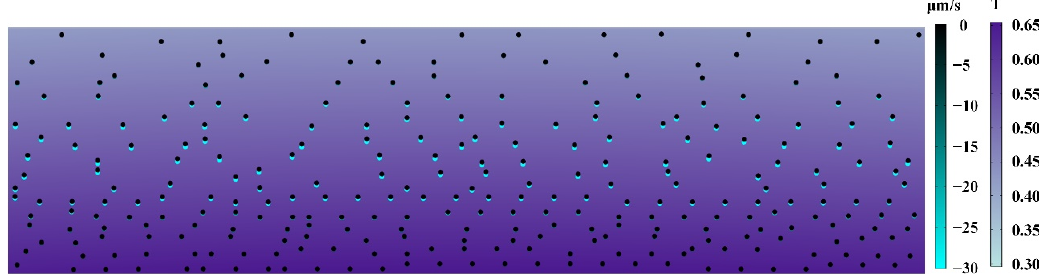
Figure 11. Metastable motion analysis of